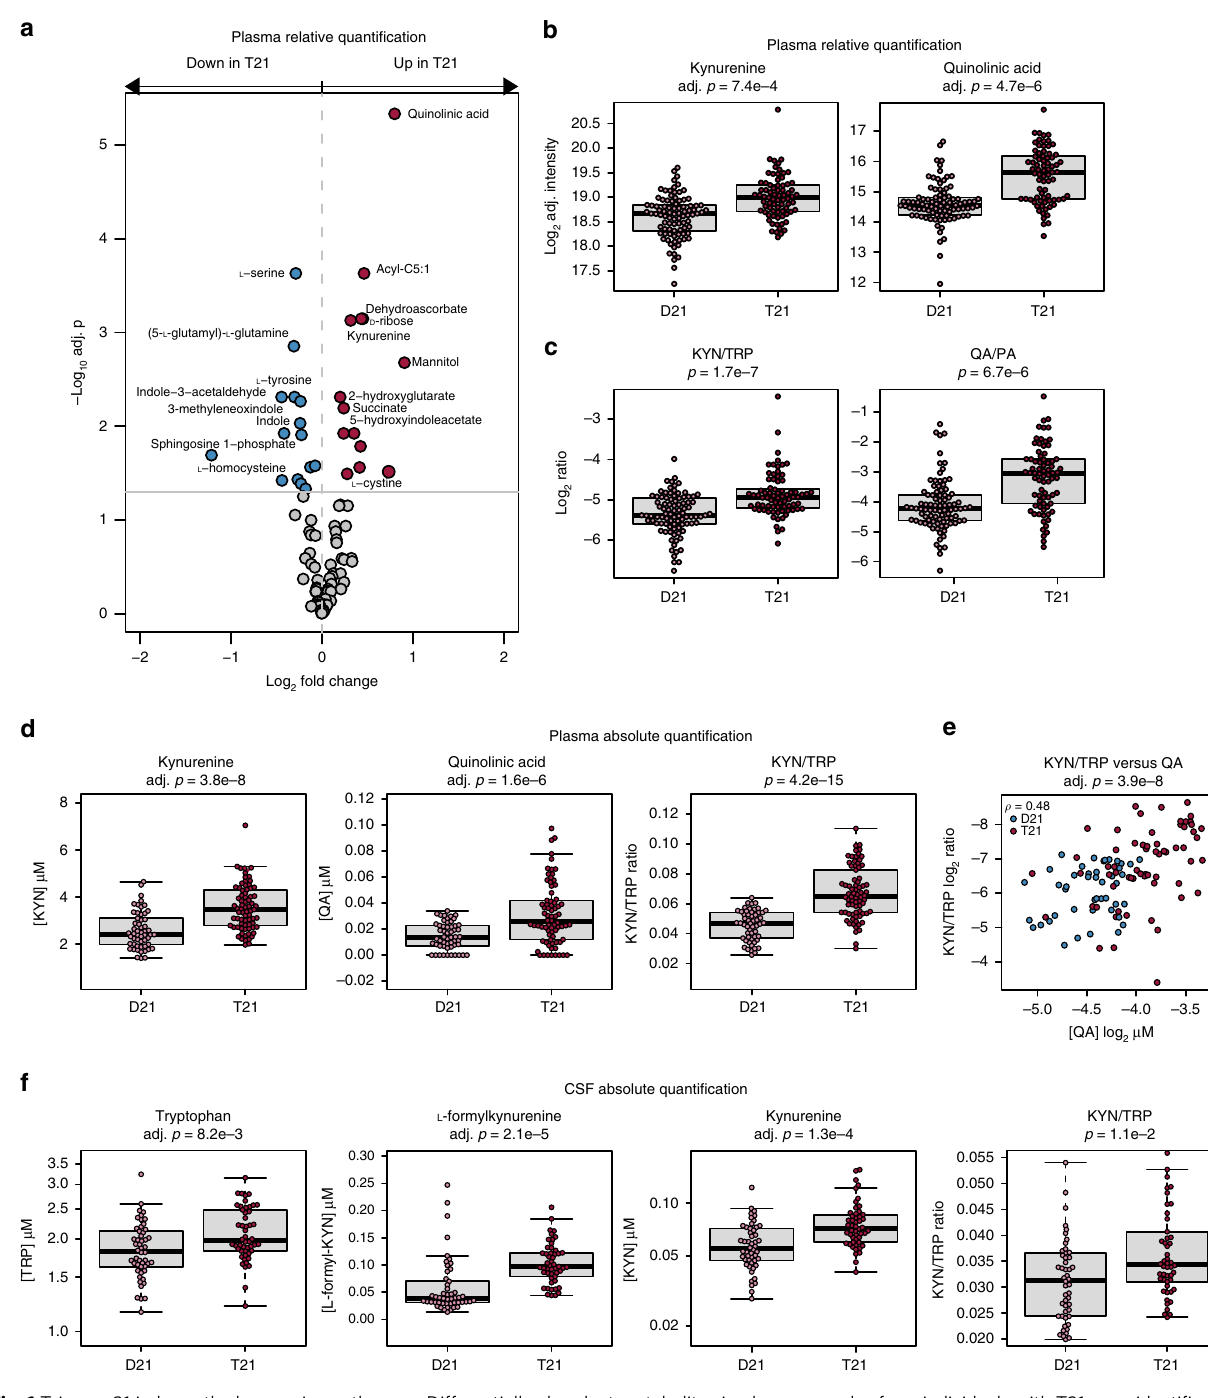
Fig. 1 Trisomy 21 induces the kynurenine pathway. a Differentially abundant metabolites in plasma samples from individuals with T21 were identi fi ed using a linear model adjusting for age, sex, and cohort. Metabolites that increased in the T21 group are shown in red and metabolites that decreased in the T21 group are blue. The horizontal gray line represents an adjusted p -value of 0.05. n = 165 independent samples, 75 with T21. b Boxplots showing the relative quanti fi cation in log 2 -adjusted intensity for signi fi cantly differentially abundant metabolites. p -values were calculated using the linear model from a and the FDR method for multiple testing correction. c Boxplots showing log 2 -adjusted ratios as indicated. p -values were calculated using an unmoderated t -test on the linear model in a . d Boxplots showing concentrations of kynurenine and quinolinic acid, as well as the ratio of kynurenine to tryptophan calculated from the absolute quanti fi cation of these metabolites in Cohort 3, n = 124 independent samples, 72 with T21. e Scatter plots comparing kynurenine/tryptophan ratios with concentrations of quinolinic acid from Cohort 3. Spearman ’ s rho ( ρ ) and FDR-corrected p -values are indicated. f Boxplots showing concentrations of tryptophan, L -formylkynurenine, and kynurenine, as well as the ratio of kynurenine to tryptophan calculated from the absolute quanti fi cation of these metabolites in the CSF of Cohort 4, n = 100 independent samples, 50 with T21. All boxplots show median, 25th, and 75th percentile values. Error bars are 1.5 times the interquartile range (IQR) or the maximum data point if < 1.5